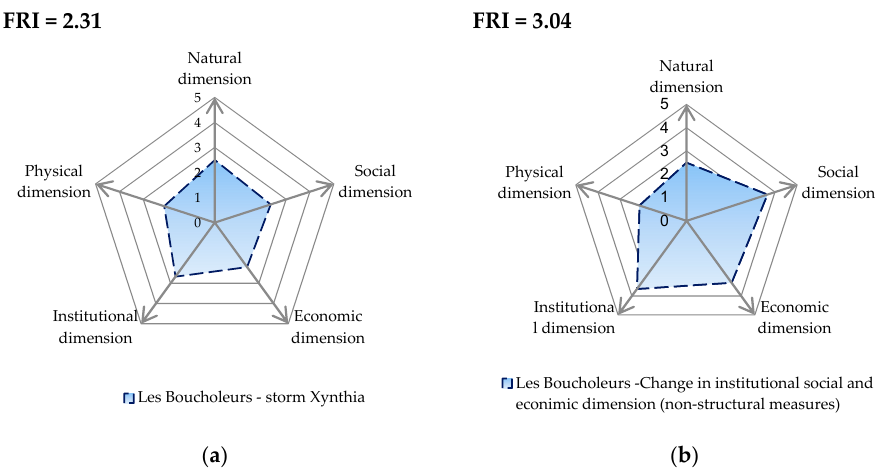
Figure 19. ( a ) Spider diagram of Les Boucholeurs for Xynthia extreme event; and ( b ) spider diagram of Les Boucholeurs assuming that non-structural measures have been implemented.